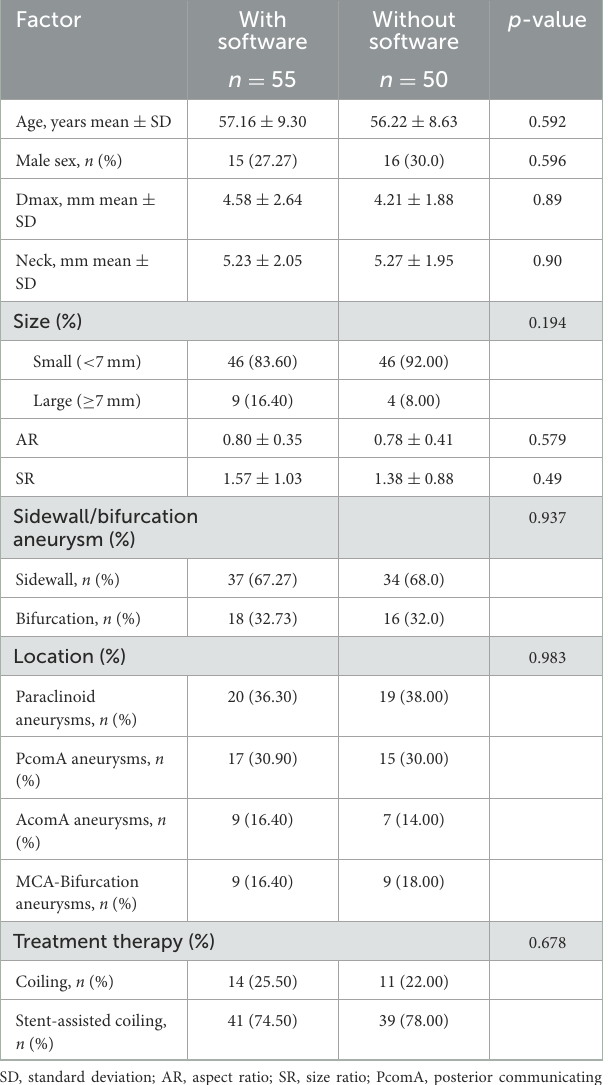
TABLE 1 Baseline clinical data and aneurysm characteristics in the software and manual groups. Factor With Without software